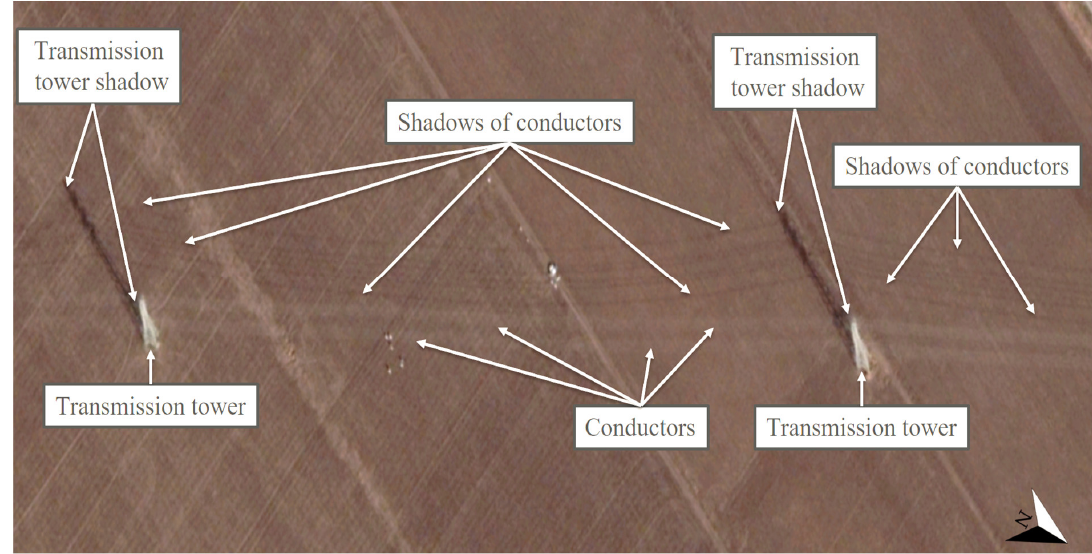
Figure 6. The shading characteristics of high-voltage transmission tower and its conductors in Buin, Chile, on 10 July 2019 at approximately 8:00 a.m. (local time), based on [41].